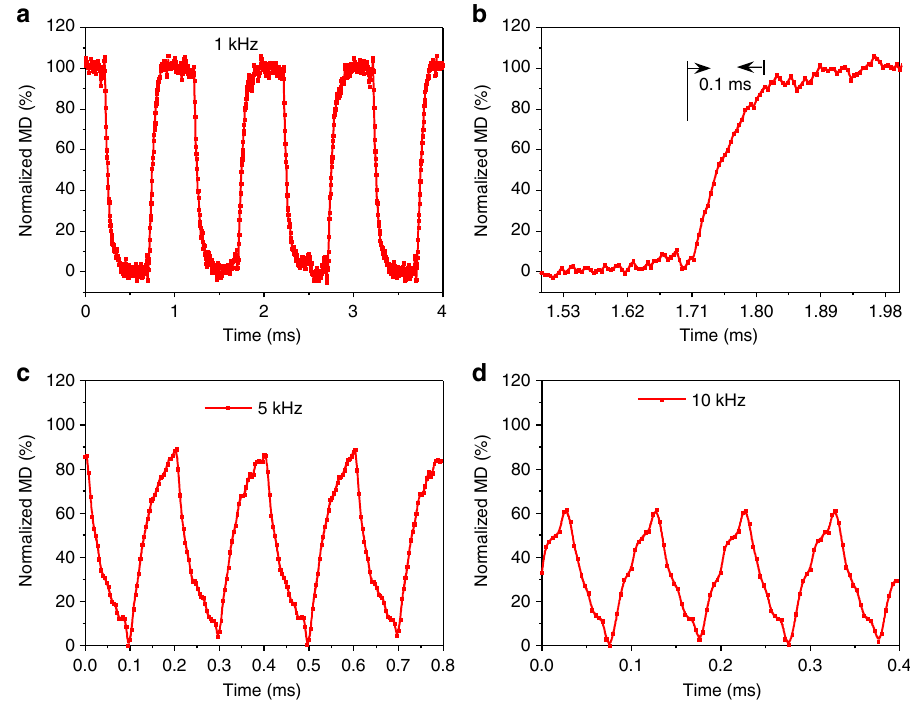
0.1 Fig. 4 Modulation speed of the intensity modulator. a The modulated terahertz beam signal under the driving signal of 1-kHz square wave with ±10 V; ( b ) the zoom-in of the rising edge in ( a ); the normalized modulation depth under±10-V square wave with ( c ) 5 kHz and ( d ) 10